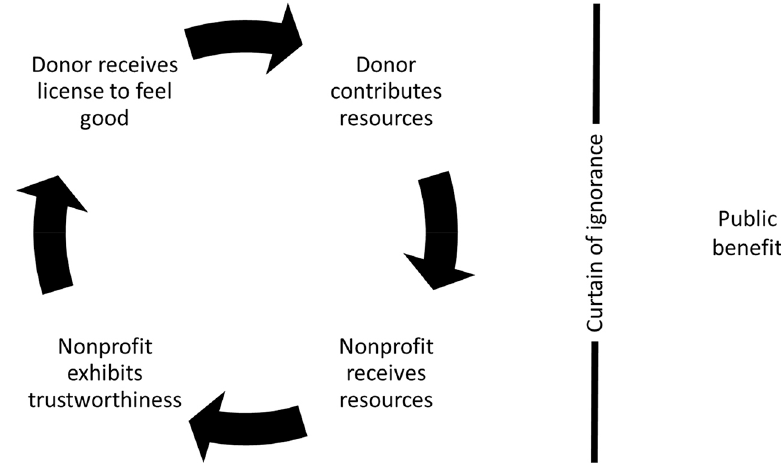
Figure 1: Iron circle of mutual benefit. Enter Figure Credit